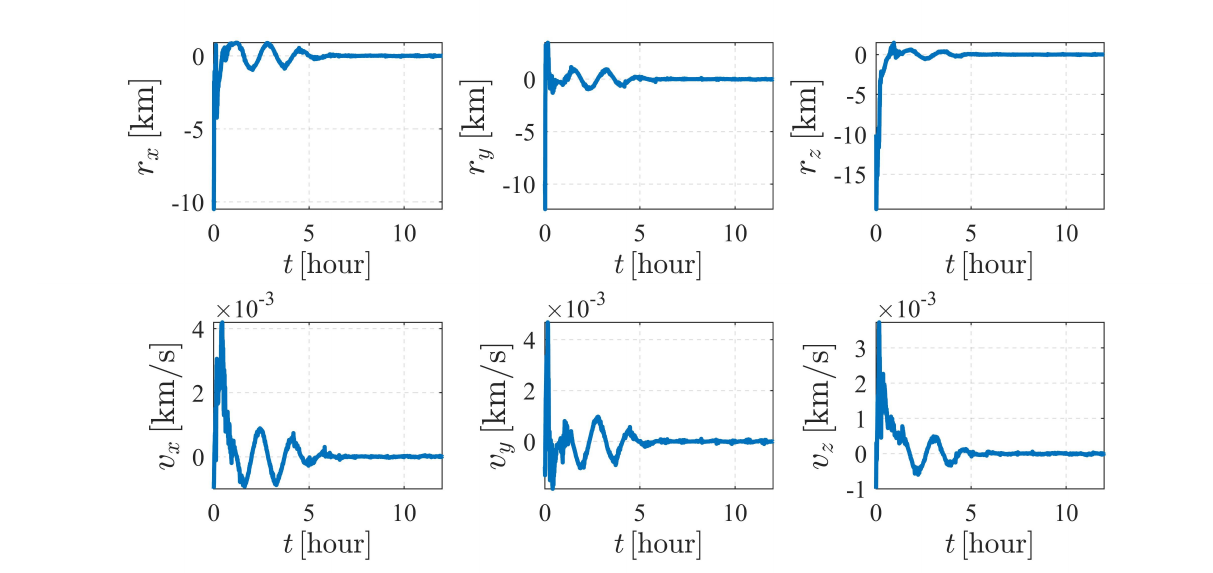
Figure 7. Orbit determination errors of spacecraft S 2 in case II